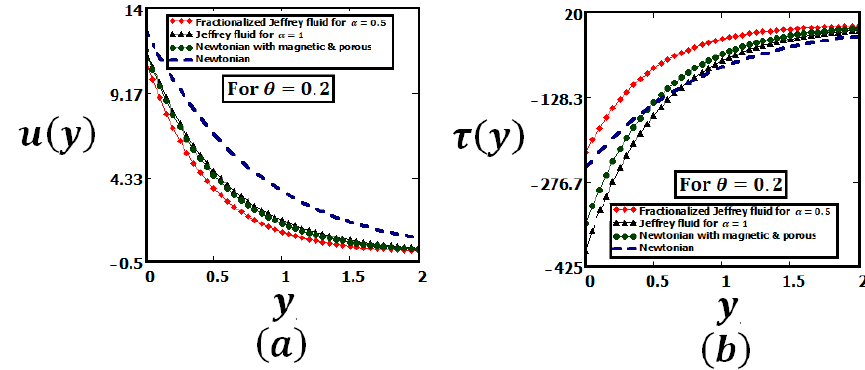
Figure 11: Profiles of the velocity field u ( y , t ) and the shear stress τ ( y , t ) for fractionalized & ordinary Jeffrey fluid given by Eqs. (16) and (21), Newtonian fluid with MHD & parous and Newtonian fluid given by Eqs. (32) and (33) for A = 1, ν = 1.427, µ = 19, λ